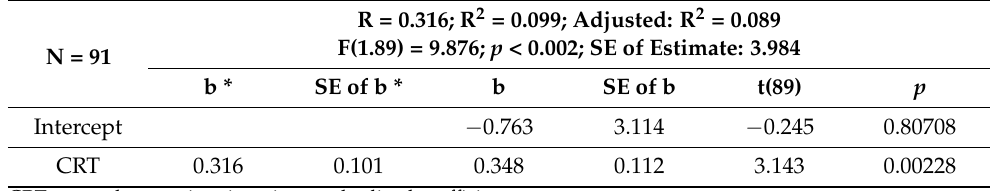
Table 3. Multiple regression—predictors of effectiveness when defending. R = 0.316; R 2 = 0.099; Adjusted: R 2 = 0.089 N = 91